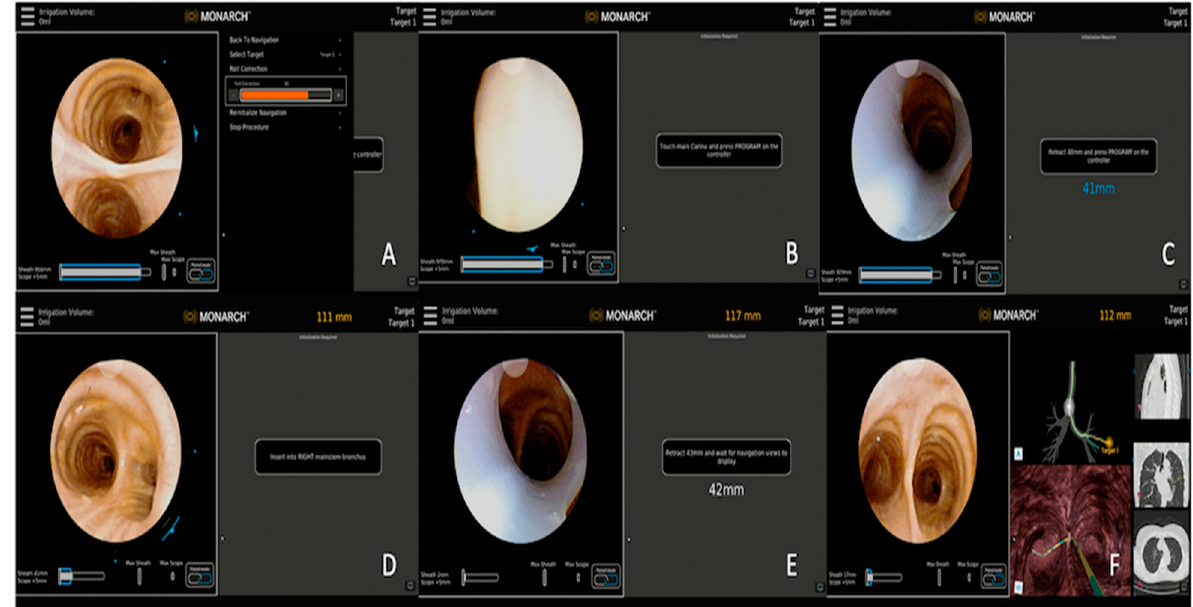
Figure 1. Steps involving registration process. ( A ) Roll correction of the bronchoscope, ( B ) touch main carina to begin registration, ( C ) retract scope back to 40 mm, ( D ) navigate to the contralateral mainstem bronchus (right side in this case), ( E ) retract scope back to the distance as recommended by the navigation device, and ( F ) begin navigation to the left upper lobe nodule .